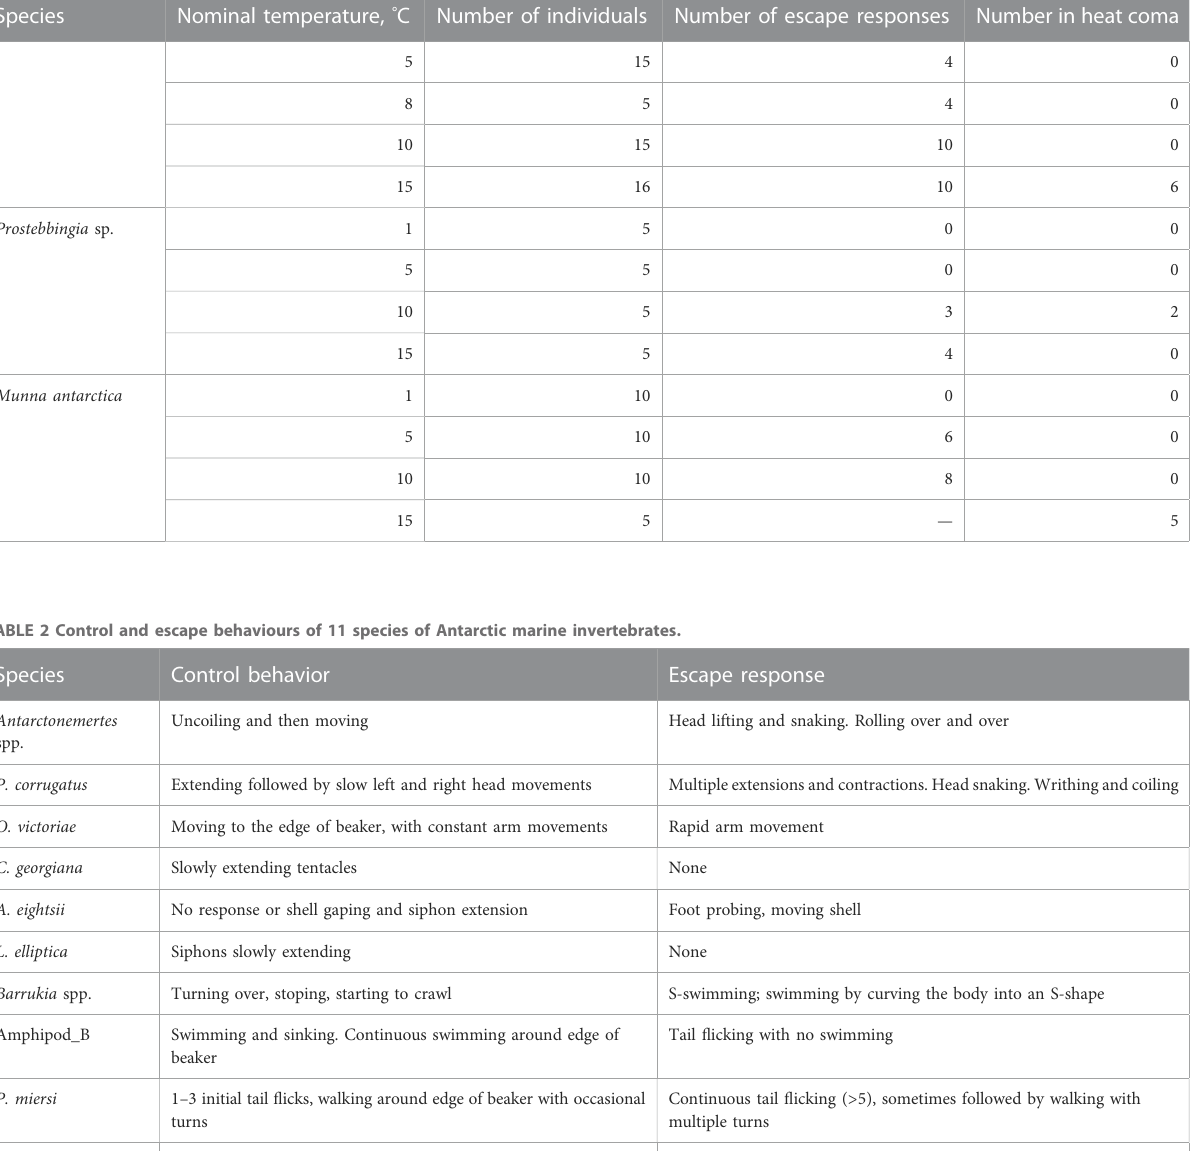
Continuous tail fl icking ( > 5), sometimes followed by walking with multiple turns